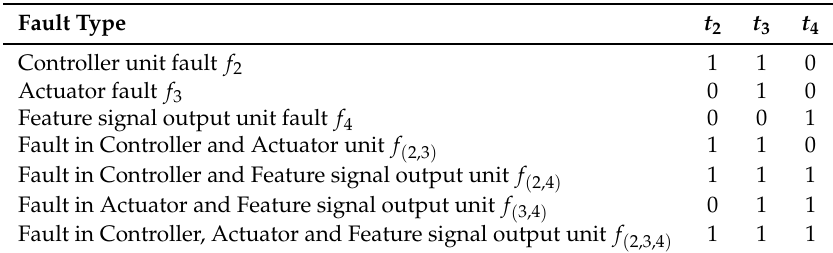
Table 3. Multiple fault dependency matrix of the system.